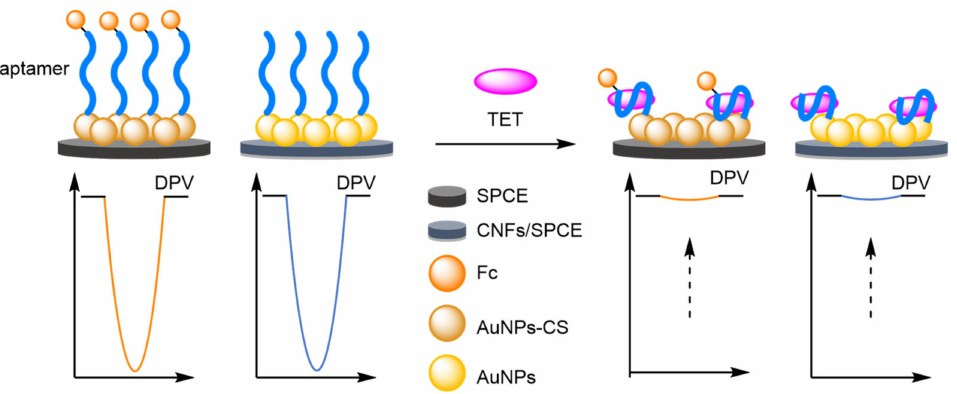
Figure 51. Schematic representation of a dual-channel aptasensor for the detection of tetracycline